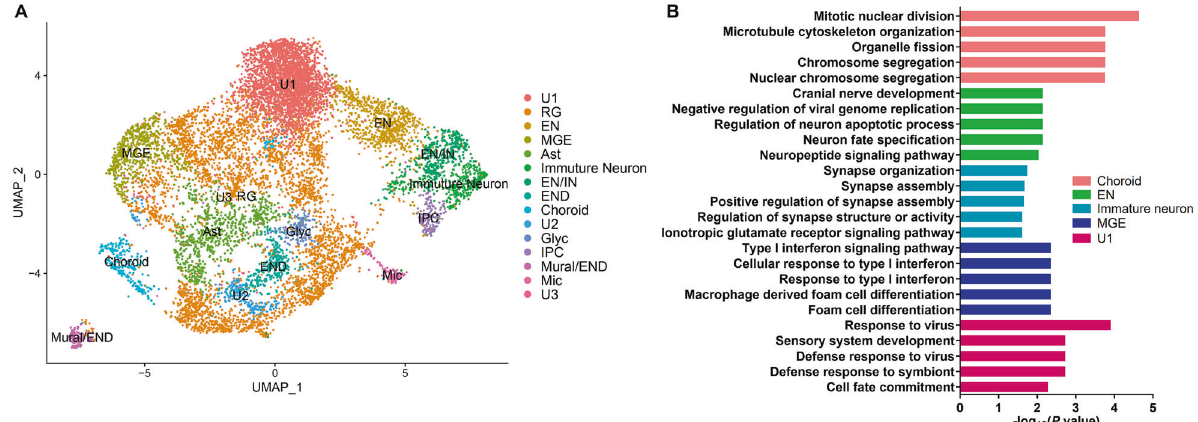
Fig. 4 scRNA-seq analysis reveals cell-type-speci fi c effects of VPA exposure in hFOs. A UMAP scatterplot for a total of 10,819 cells derived from U1M and U2F hFOs. Ast astrocyte, Choroid choroid plexus, EN excitatory neuron, END endothelia, Glyc glycolysis, IN inhibitory neuron, IPC intermediate progenitor cells, MGE medial ganglionic eminence, Mic microglia, Mural mural cell, RG radial glia, U1 – U3 unknown cell clusters 1 – 3. B GO enrichment analysis for DEGs identi fi ed in the annotated cell types of hFOs. The top fi ve GO terms are shown. identi fi ed cell-type-speci fi c functions for the VPA-induced DEGs progenitor cells (IPC), medial ganglionic eminence (MGE), radial (Fig. 4B and Supplementary Table 4). For example, DEGs in glia (RG), immature neuron, excitatory and inhibitory neuron (EN choroids were enriched with mitotic nuclear division, multiple and IN), and microglia-like cells were identi fi ed (Fig. 4A). RG cells neural functions including neuron death, differentiation, and and neurons (7% EN, 3% immature neuron, 3% EN/IN) accounted migration. DEGs in EN and immature neurons were also enriched for 32 and 13% of the total cells, respectively (Supplementary Fig. with multiple neural functions such as neural development, 7). DGE analysis showed that VPA affected the expression of genes synapse organization, and synaptic transmission. Interestingly, in the choroid, EN, immature neuron, MGE cells, and unknown cell VPA-induced DEGs in MGE and the unknown cluster 1 were cluster 1 (Supplementary Table 4). GO enrichment analysis